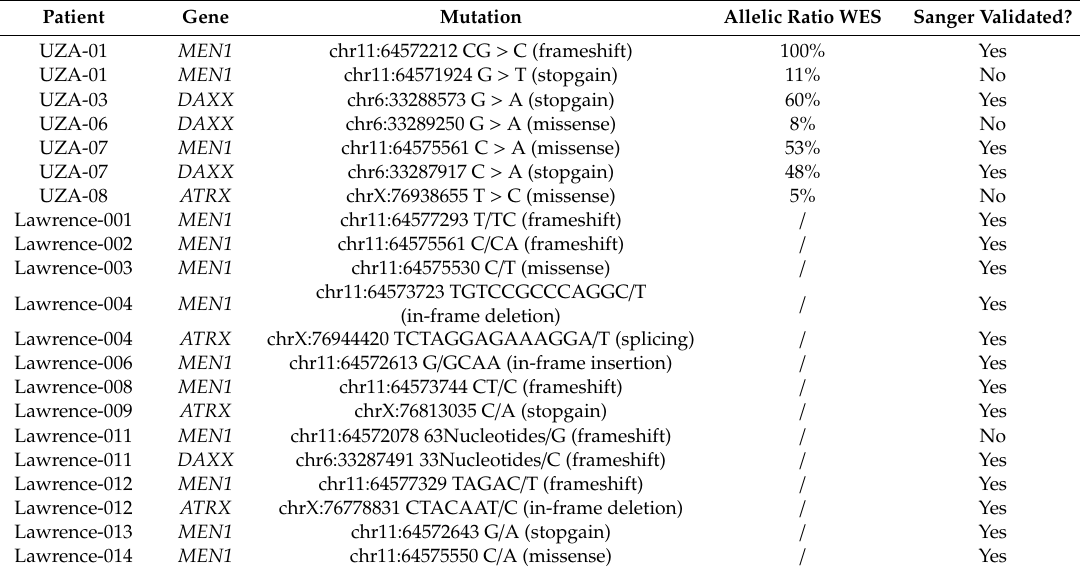
Table 2. Overview of mutations in DAXX, ATRX or MEN1 identified in 25 patients (UZA-01–UZA-10 and